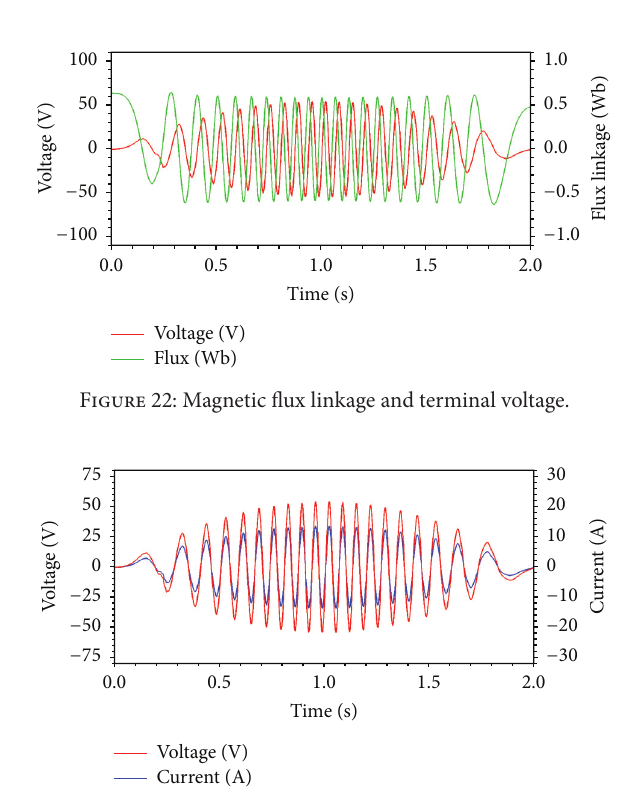
Figure 21: The induced voltage and current.